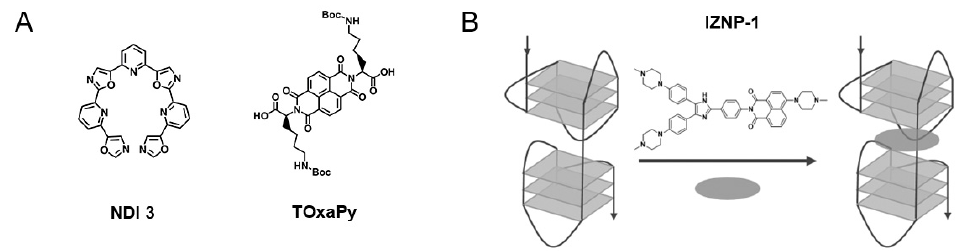
Figure 3. Examples of selective DNA G4 ligands. ( A ) Chemical structures and family of the ligands TOxaPy and NDI 3. ( B ) Chemical structure of IZNP-1 and proposed binding model of the intercalation of IZNP-1 into two telomeric G4 units. Adapted from ref. [77].